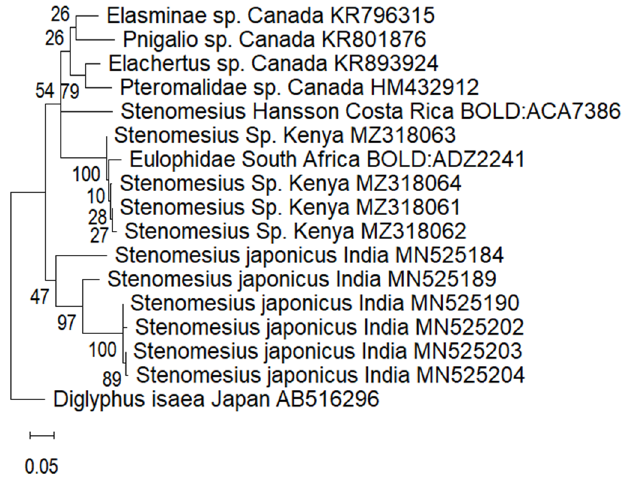
Figure 2. Maximum likelihood phylogenetic tree for the mitochondrial COI sequences of Stenomesius species from GenBank and BOLD together with the specimen identified in our study.